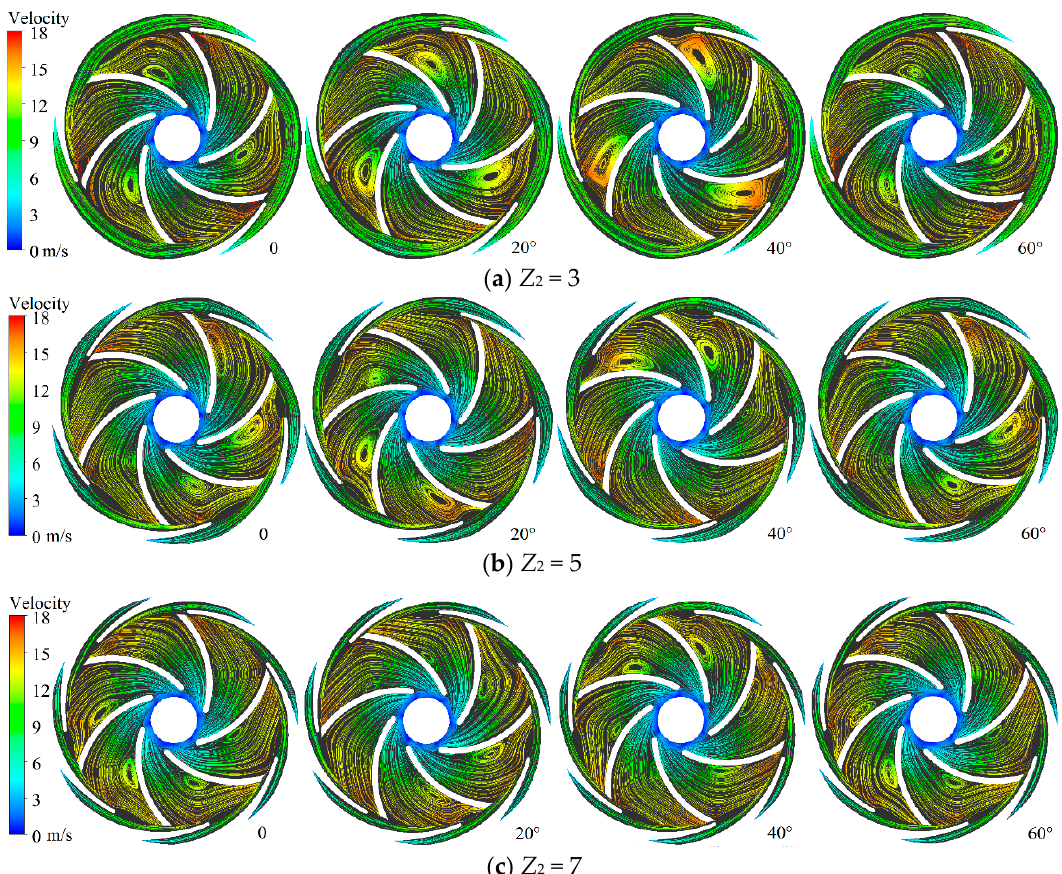
Figure 13. Evolution processes of the transient flow field inside the impeller and guide vane with the different blade numbers of the guide vane.